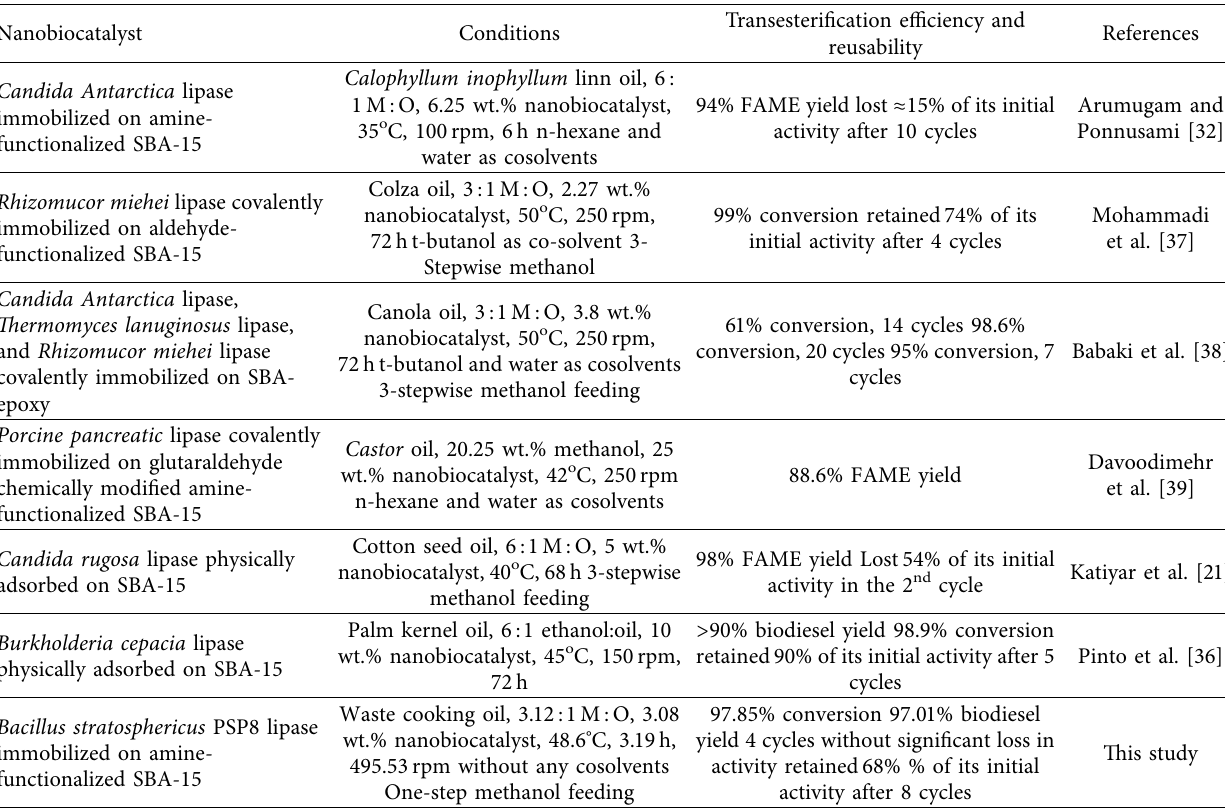
2 –Pr-SBA-15 and the previously published lipase immobilized